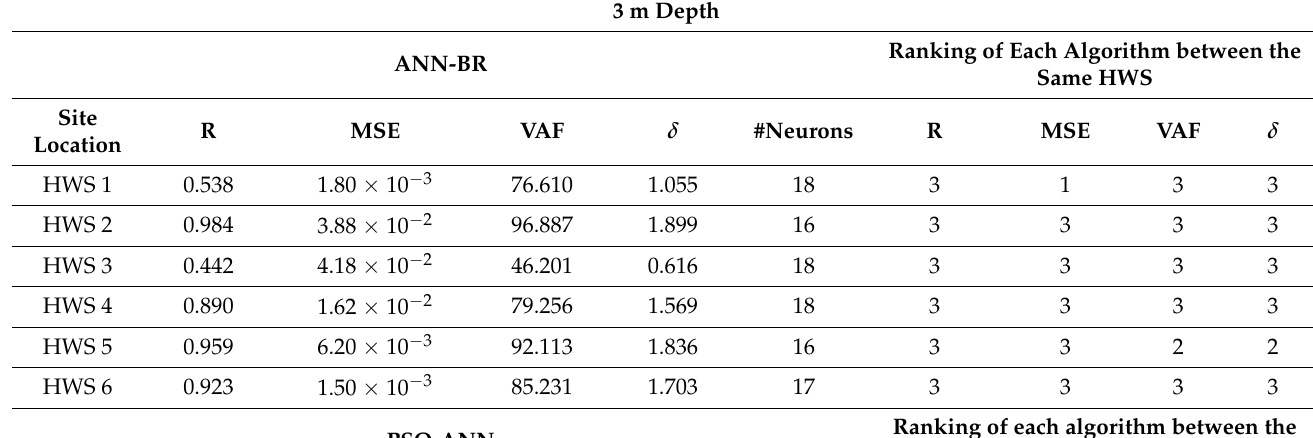
Table A6. Summary of model performance indices and ranks for predictive models at 3 m